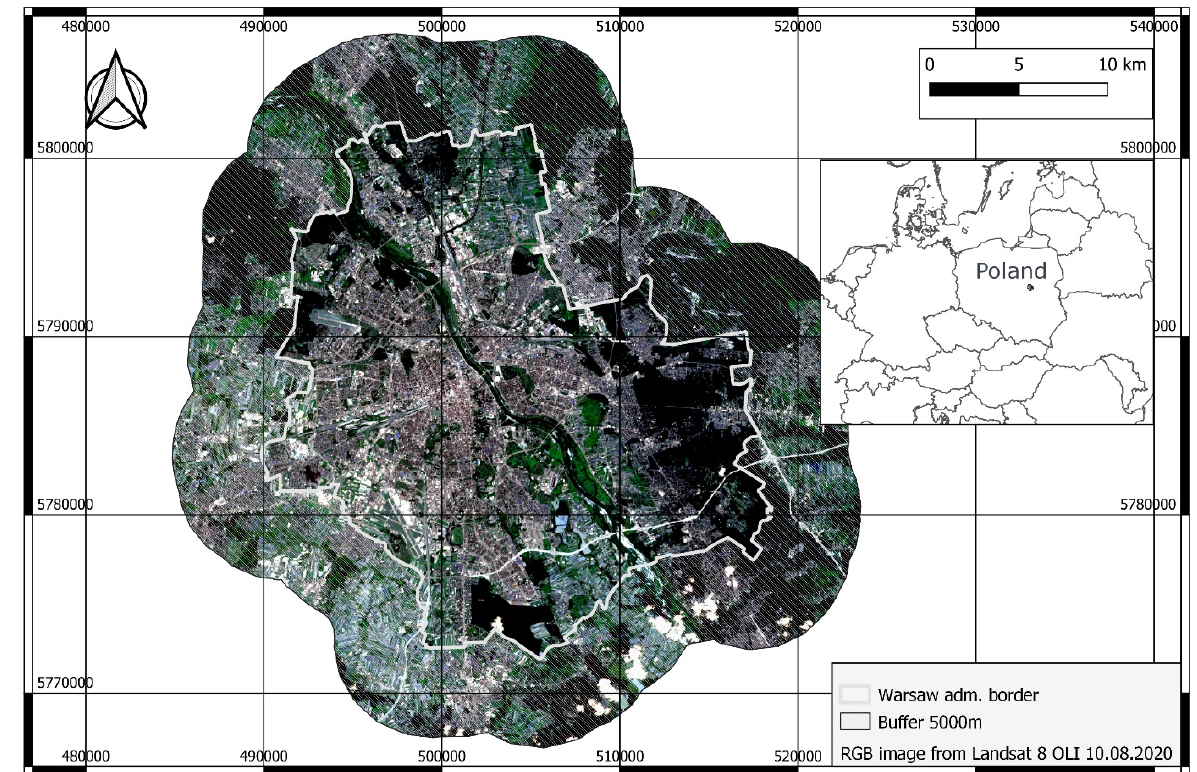
Figure 1. Study area ‐ the city of Warsaw and the 5 km buffer.